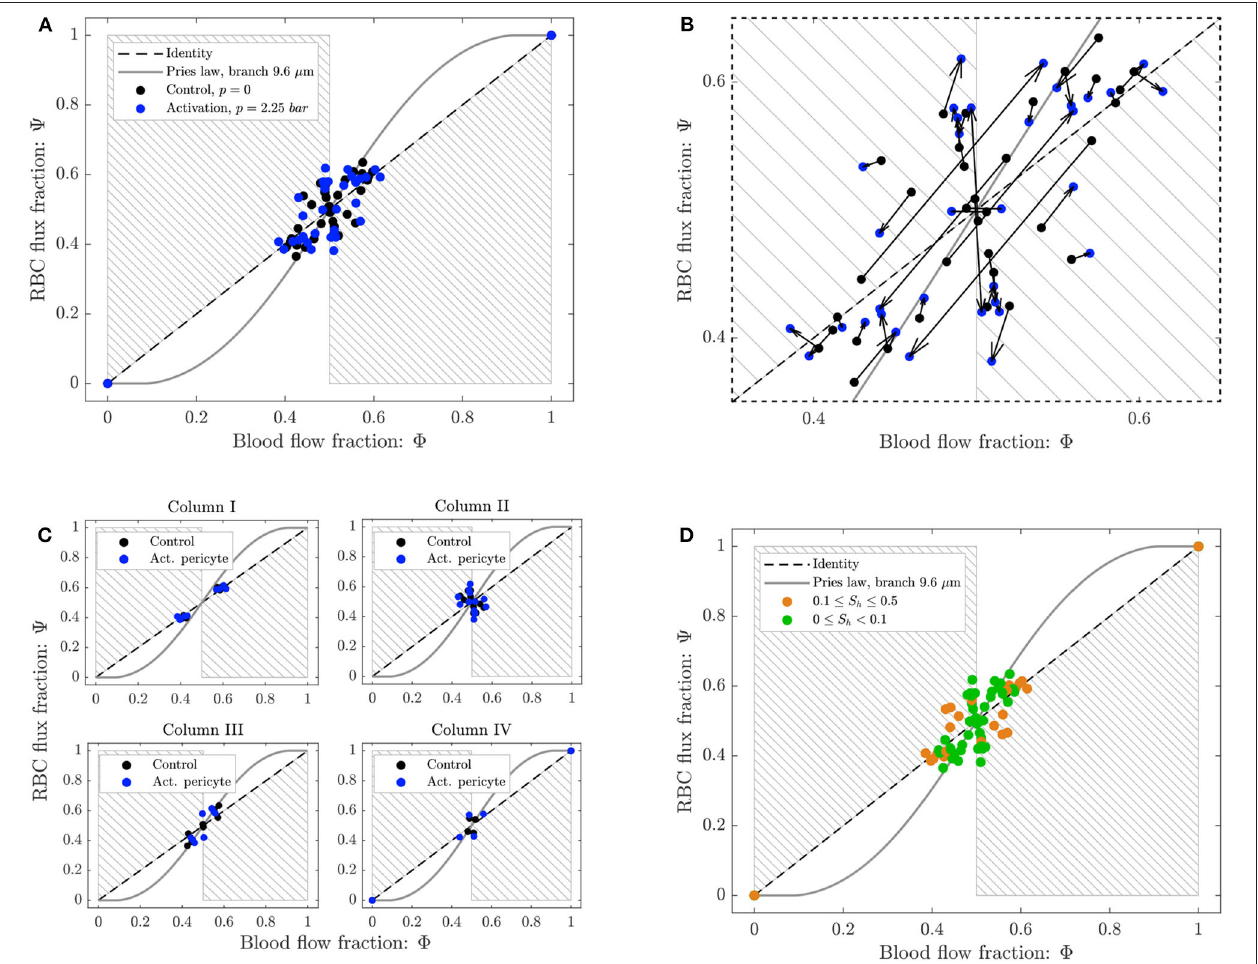
FIGURE 8 | Phase separation results for pericyte activation. (A) Blood flow fraction vs. RBC flux fraction for the control case (black, 1 P the inflation of the pressure chamber (blue, 1 P 9.8 mbar , p 2.25 bar ). (B) Magnified region of (A) . The arrows indicate the change of the phase separation for = = each bifurcation. (C) Phase separation data shown in (A) grouped with respect to column ordering defined in Figure 2 . (D) Phase separation data shown in (A) grouped in function of the skewness factor of the hematocrit profile in the parent vessel of each bifurcation. For all plots circles represent data from this study. The gray continuous line is the empirical law from Pries and Secomb (2008). The dashed line is the identity line representing the proportional separation of blood and RBCs (no phase separation). Data points in the gray shaded regions indicate an inversion of the Zweifach-Fung effect ( Clavica et al., 2016; Shen et al.,